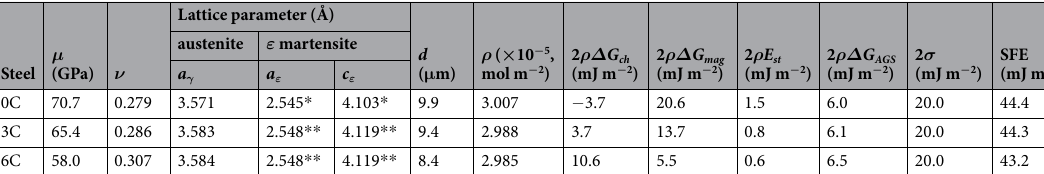
Lattice parameter (Å)